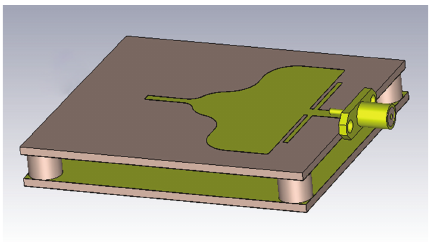
Figure 3: Perspective view of the proposed antenna.